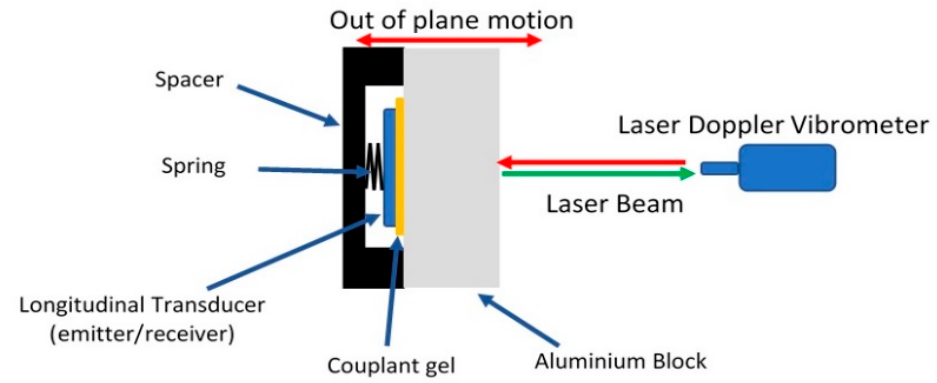
Figure 6. Schematic diagram of voltage to meter conversion apparatus.